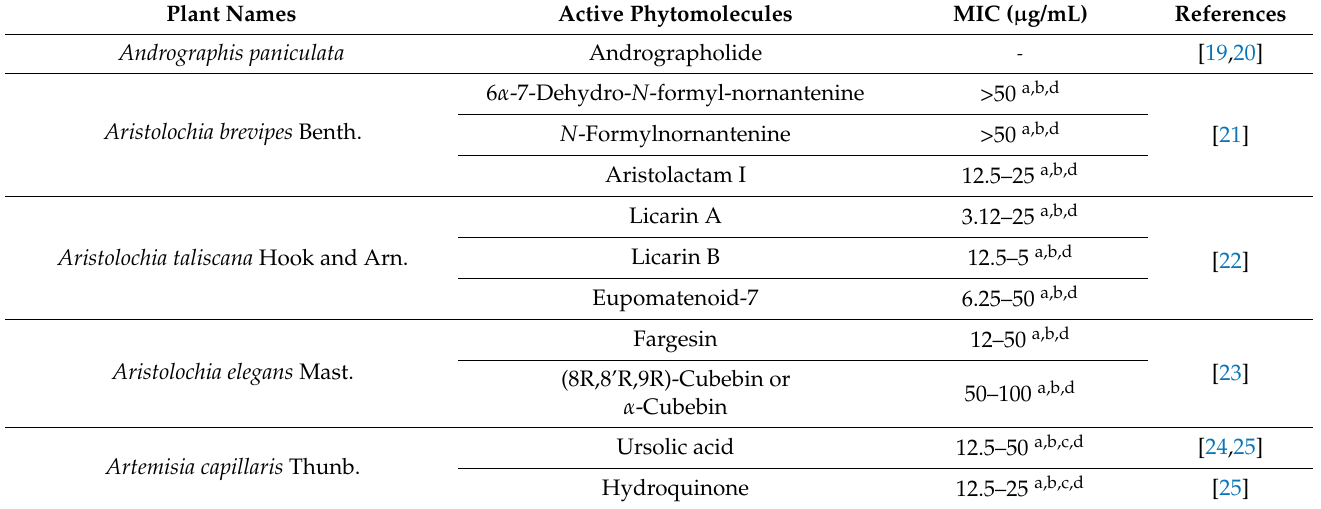
Table 1. Plants and their molecules active against different Mycobacterium strains. a mono-resistant clinical and non- clinical isolates, b multidrug-resistant (MDR) clinical and non-clinical isolates, c mycobacteria other than M. tuberculosis , d Mycobacterium